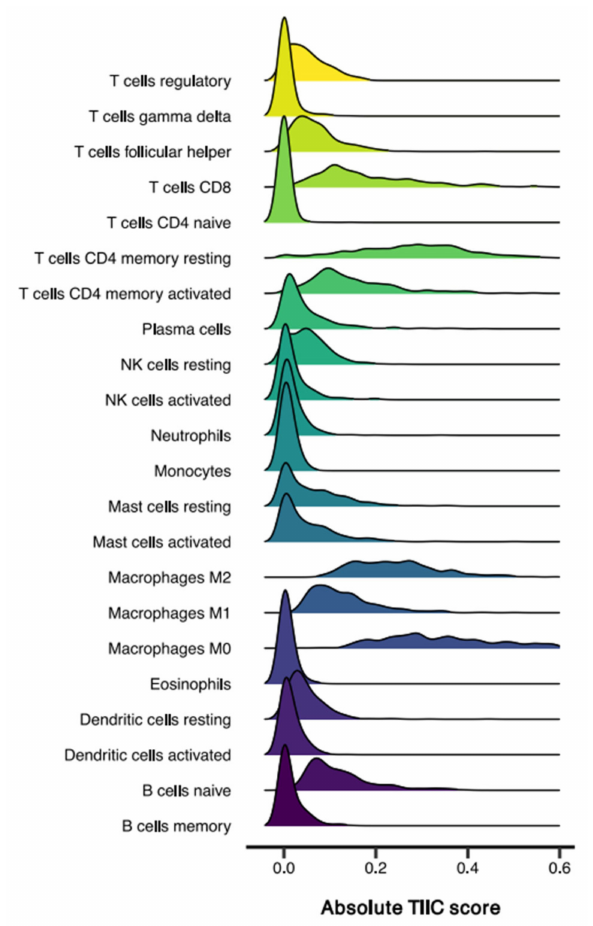
Figure 1. Distribution of tumor-infiltrating immune cell (TIIC) subsets in 359 colon adenocarcinoma tumors. Ridgeline plot of absolute infiltration of the 22 TIIC subsets, as defined by